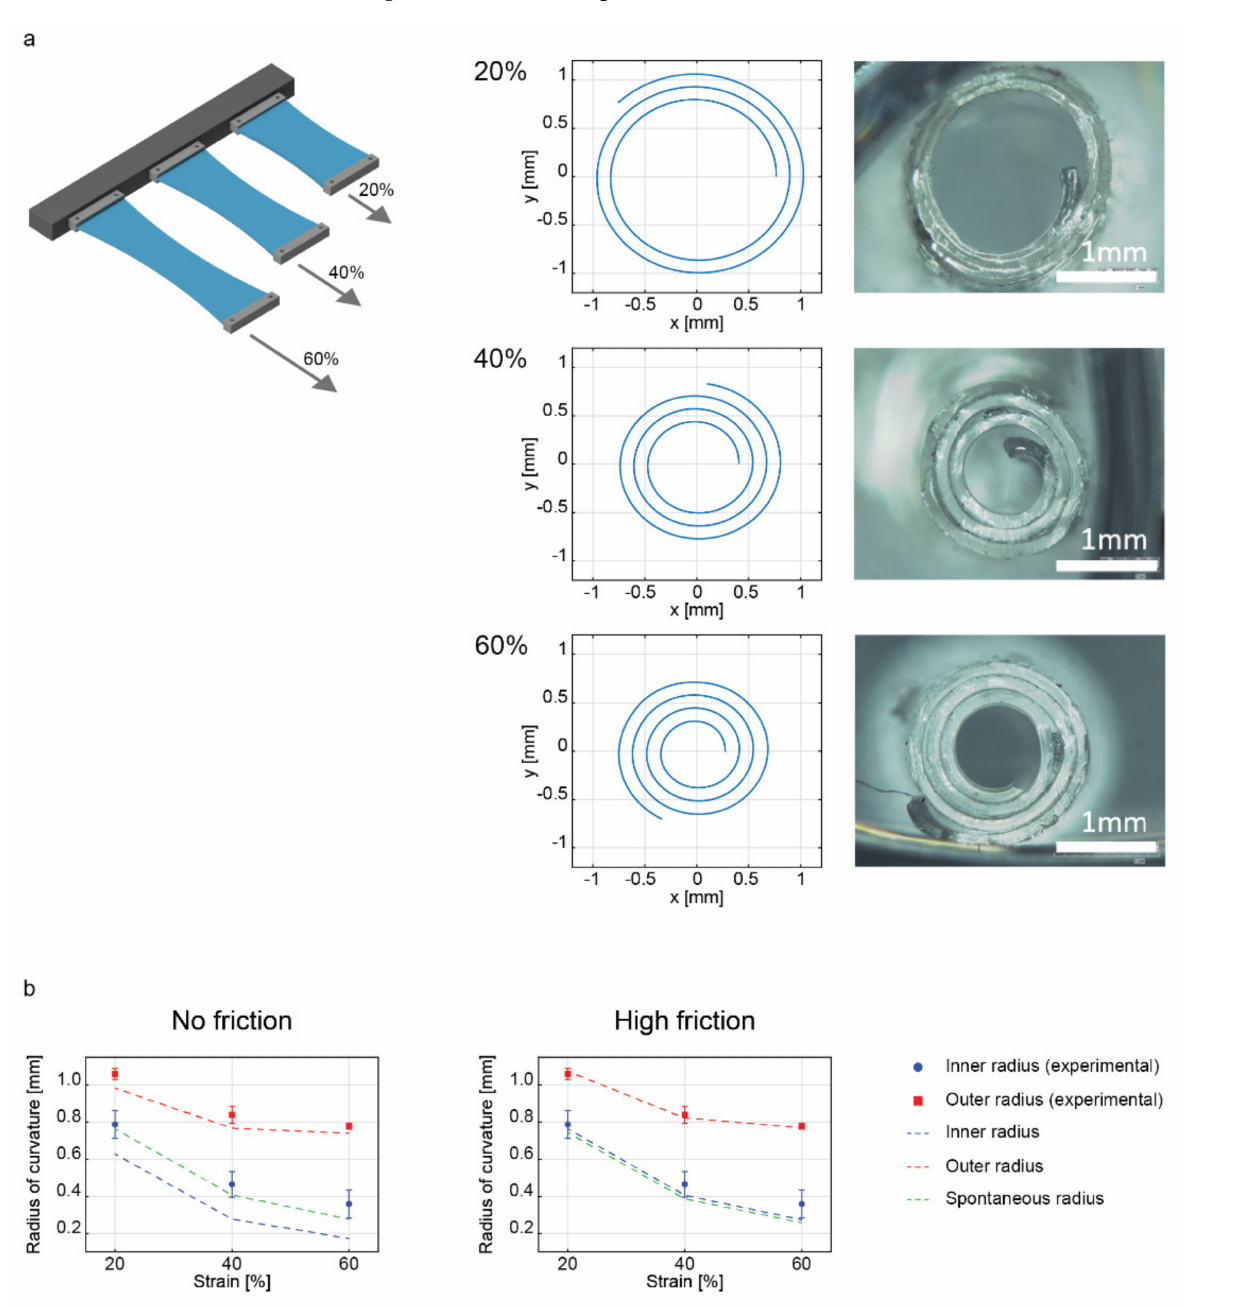
Figure 2. ( a ) Scheme of different strain values applied to top layers; simulation of rolled bilayers at 20%, 40%, and 60% strain based on model prediction, and microscope images of rolled bilayers fabricated using a strain of 20%, 40%, and 60%. ( b ) Plots compare experimental data and model predictions for rolled bilayers at different strain values under the assumptions of no friction (left) and high friction